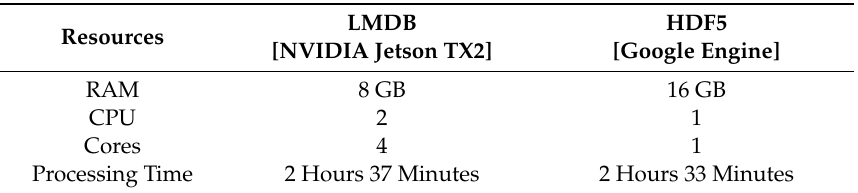
Table 4. Data preprocessing resource comparison between lightning memory-mapped database (LMDB) and hierarchical data format version 5 (HDF5).